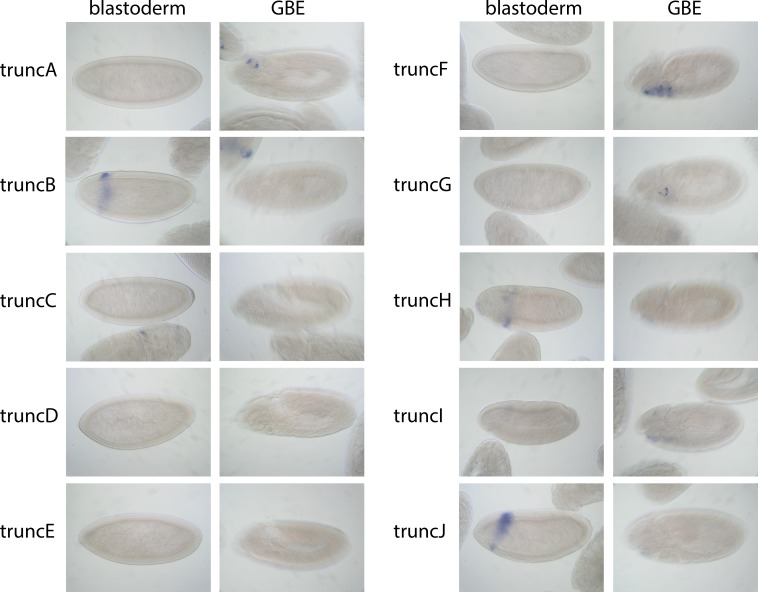
Embryo images of truncA – truncJ expression patterns.See also Figure 3. Representative images from either stg 5–7 (‘blastoderm’) or germ band-extended embryos (‘GBE’; stg. 10) containing the indicated EO053*>GAL4 reporter constructs and probed for GAL4 mRNA expression by in situ hybridization. Note absence of any embryos expressing a zen2-like pattern at the early stages; only truncF and truncG express GAL4 in the pb-like territory in GBE embryos.